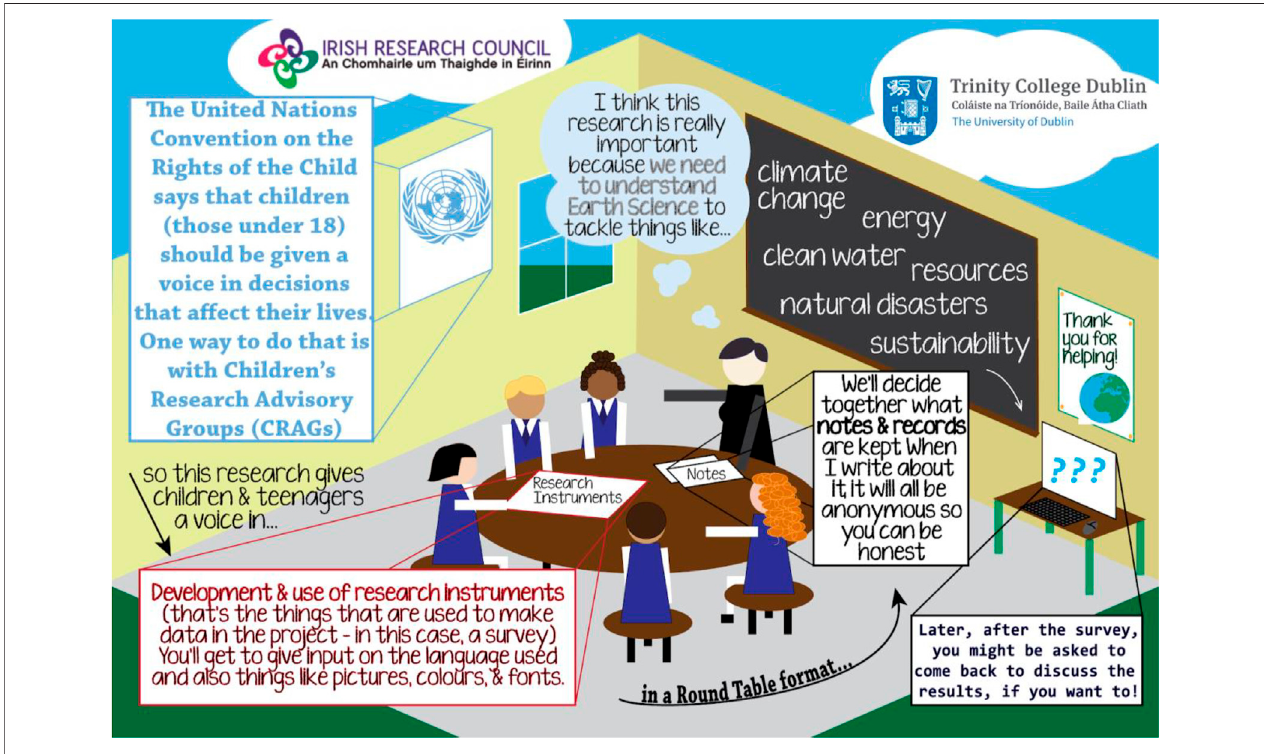
FIGURE 1 | Children ’ s Research Advisory Groups: An excerpt (edited for clarity) from the information sheet given to student co-researchers as part of an ongoing geoscience education research project undertaken by the authors (Artist is EN).